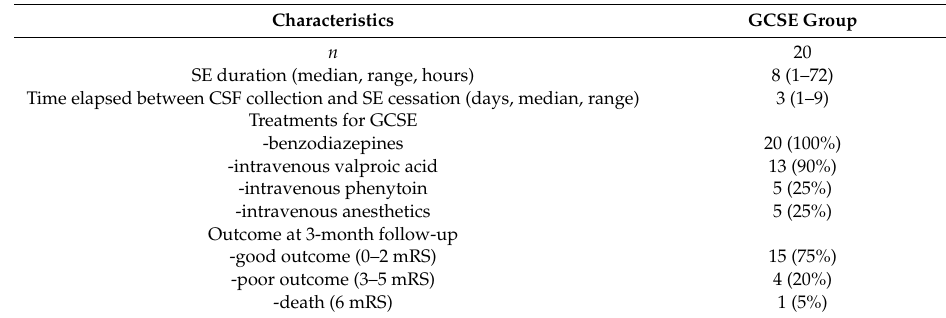
Table 2. Status epilepticus patients’